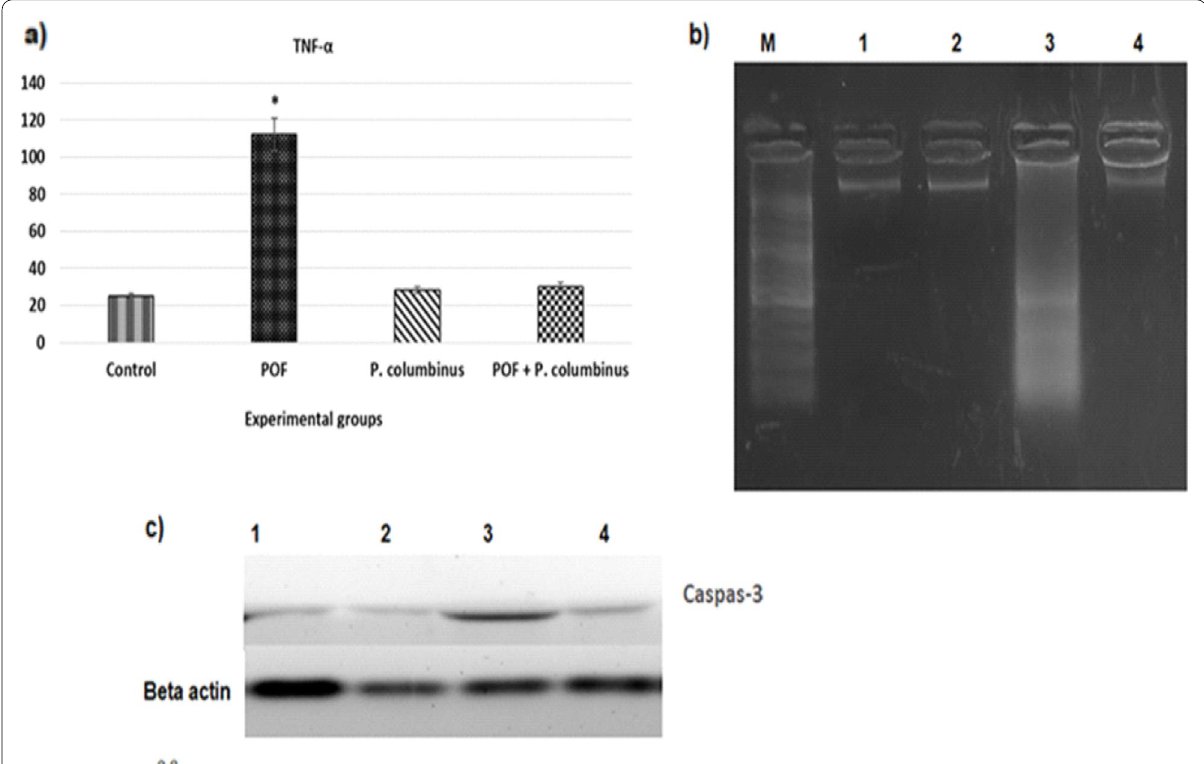
Fig. 2 a Oral treatment of P. columbinus extract (100 mg/kg) on TNF-α in rat treated with CTX chemotherapy. Each bar is represented by a mean SE ( n 8). Asterisk indicates a significant difference from the control and treated with P. columbinus extract. b Agarose gel electrophoresis shows = DNA fragmentation. Lane 1: M: DNA marker with 100 bp. Lane 2: control group. Lane 3: normal rats administered P. columbinus extract. Lane 3: POF model. Lane 4: CTX P. columbinus extract. c Western blot analysis for protein expression of caspase-3 and beta actin in different studied groups. + Lane 1: control group. Lane 2: normal rats administered P. columbinus extract. Lane 3: POF group. Lane 4: CTX expressed as mean SD of three independent experiments. * p < 0.05 ≠ control and P. columbinus extract ±